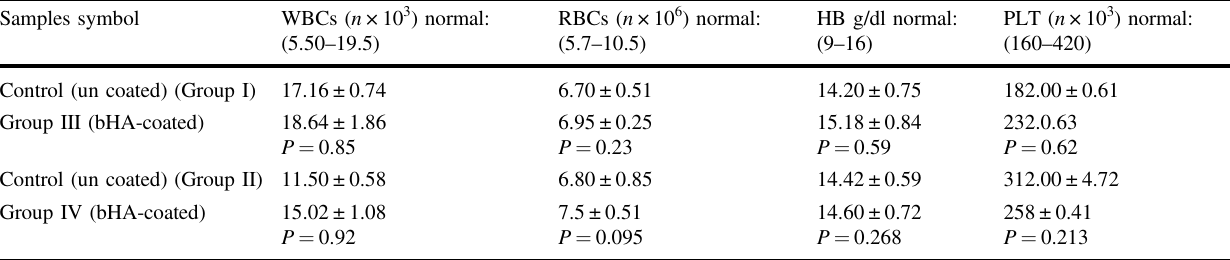
Table 3 Toxicity effects on RBCs, WBCs, hemoglobin, and PLT count at 3 days post surgery Samples